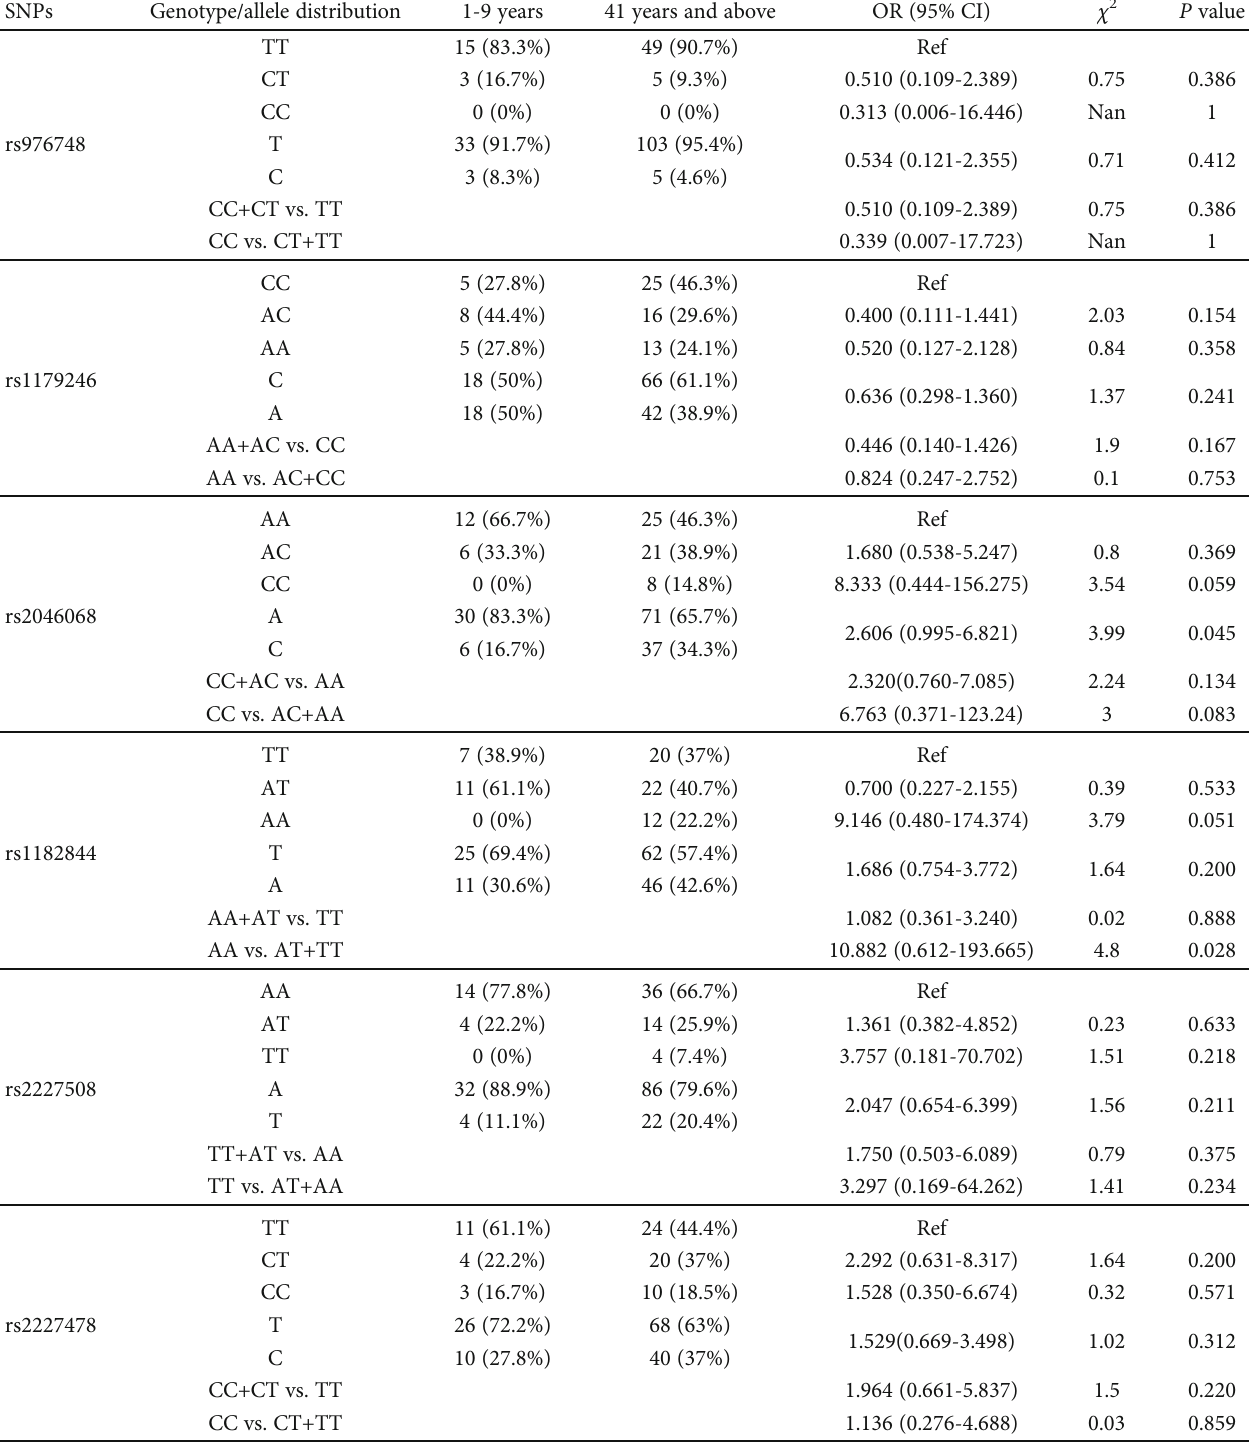
Table 5: Genotype distribution and allele frequency of IL-22 SNPs in group 1-9years of age compared to 41 years and above age